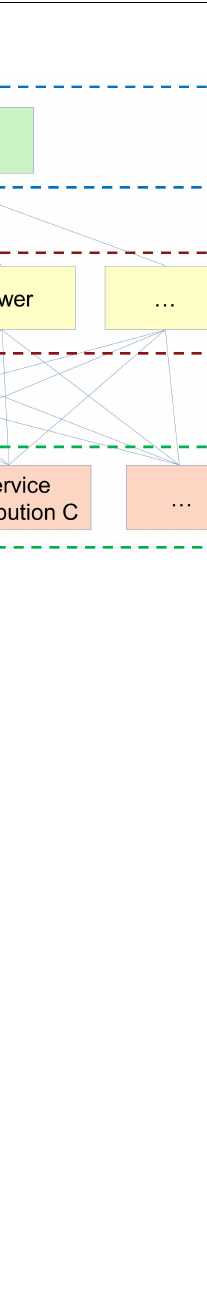
Figure 7. Process of AHP decision